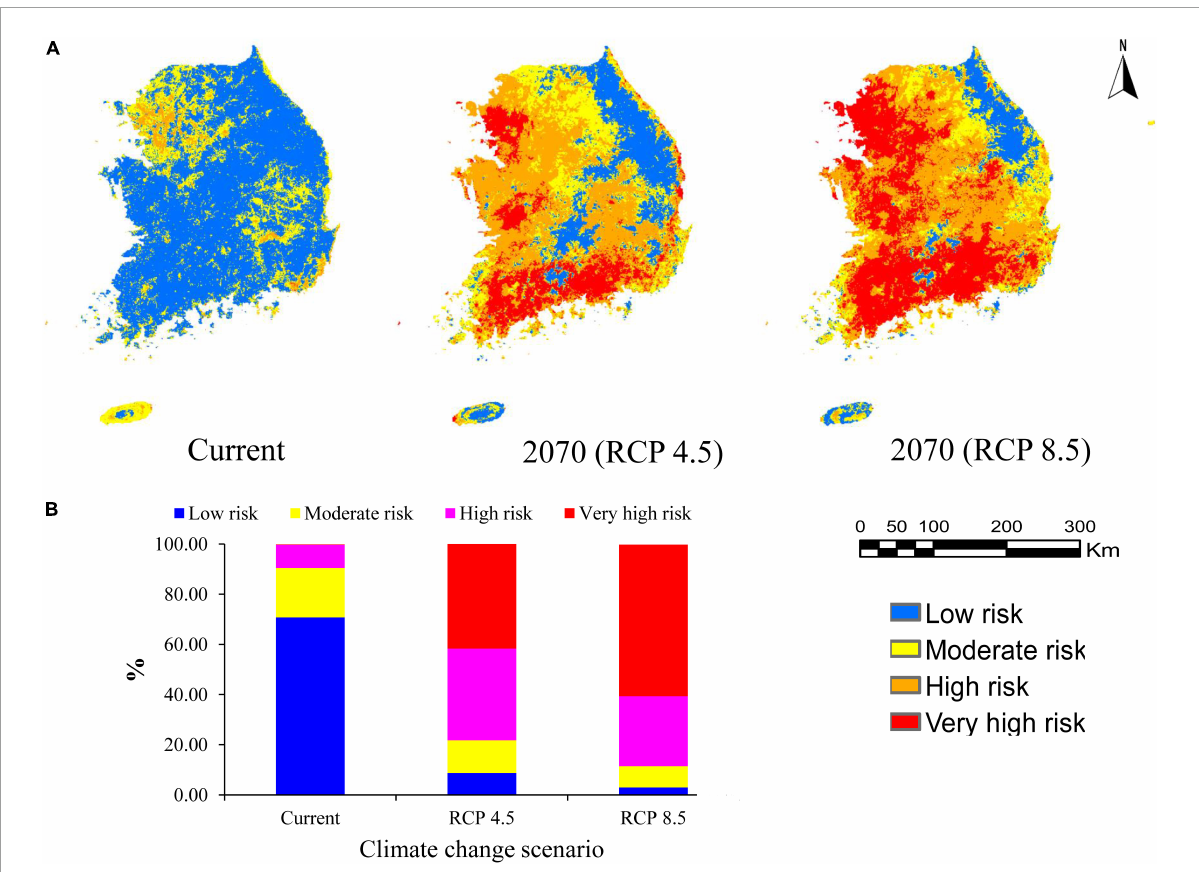
FIGURE4 Prediction of invasion risk of 12 EDAPS under the current and future climate change conditions (RCP 4.5 and RCP 8.5) in South Korea. (A) Color-coded maps of South Korea showing areas of potential invasion risk using the RF model. Colors indicate the different risk categories. (B) Segmented bar graphs showing estimated percentages (%) of the different invasion risk categories relative to the total area of the